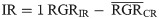
Effects of neighborhood composition on resistance: (A) constitutive resistance (CR) and (B) induced resistance (IR).Resistance was measured using the relative growth rates (RGR) of Leptinotarsa juncta beetle larvae (CR = 1 − RGRCR and IR=1 RGRIR− RGR¯CR). Solid grey and black lines/circles are for genotypes #111 and 5, respectively. Dashed grey and black lines and hallow circles are for genotypes #101 and 202, respectively. P-values are for interactions between the four plant genotypes and neighborhood components. Y values are partial residuals after accounting for the effects of the other neighborhood components.